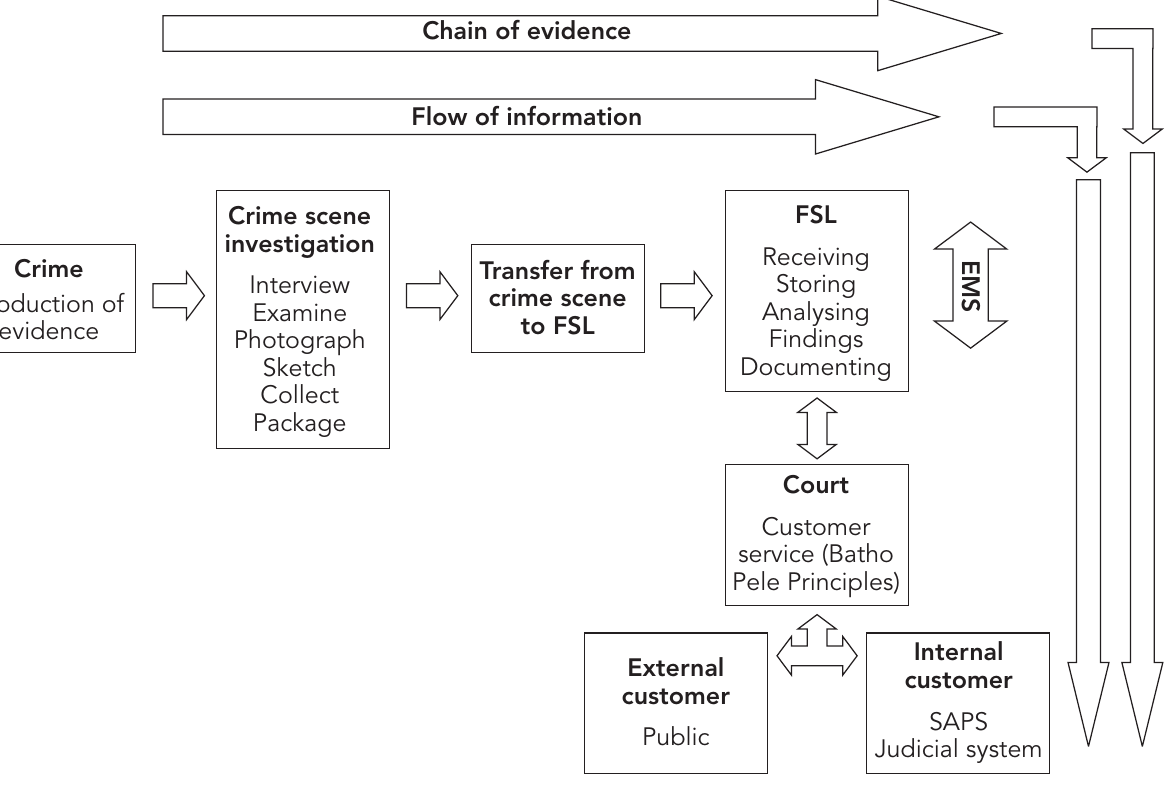
Figure 1: Evidence supply chain (Compiled for the purpose of the